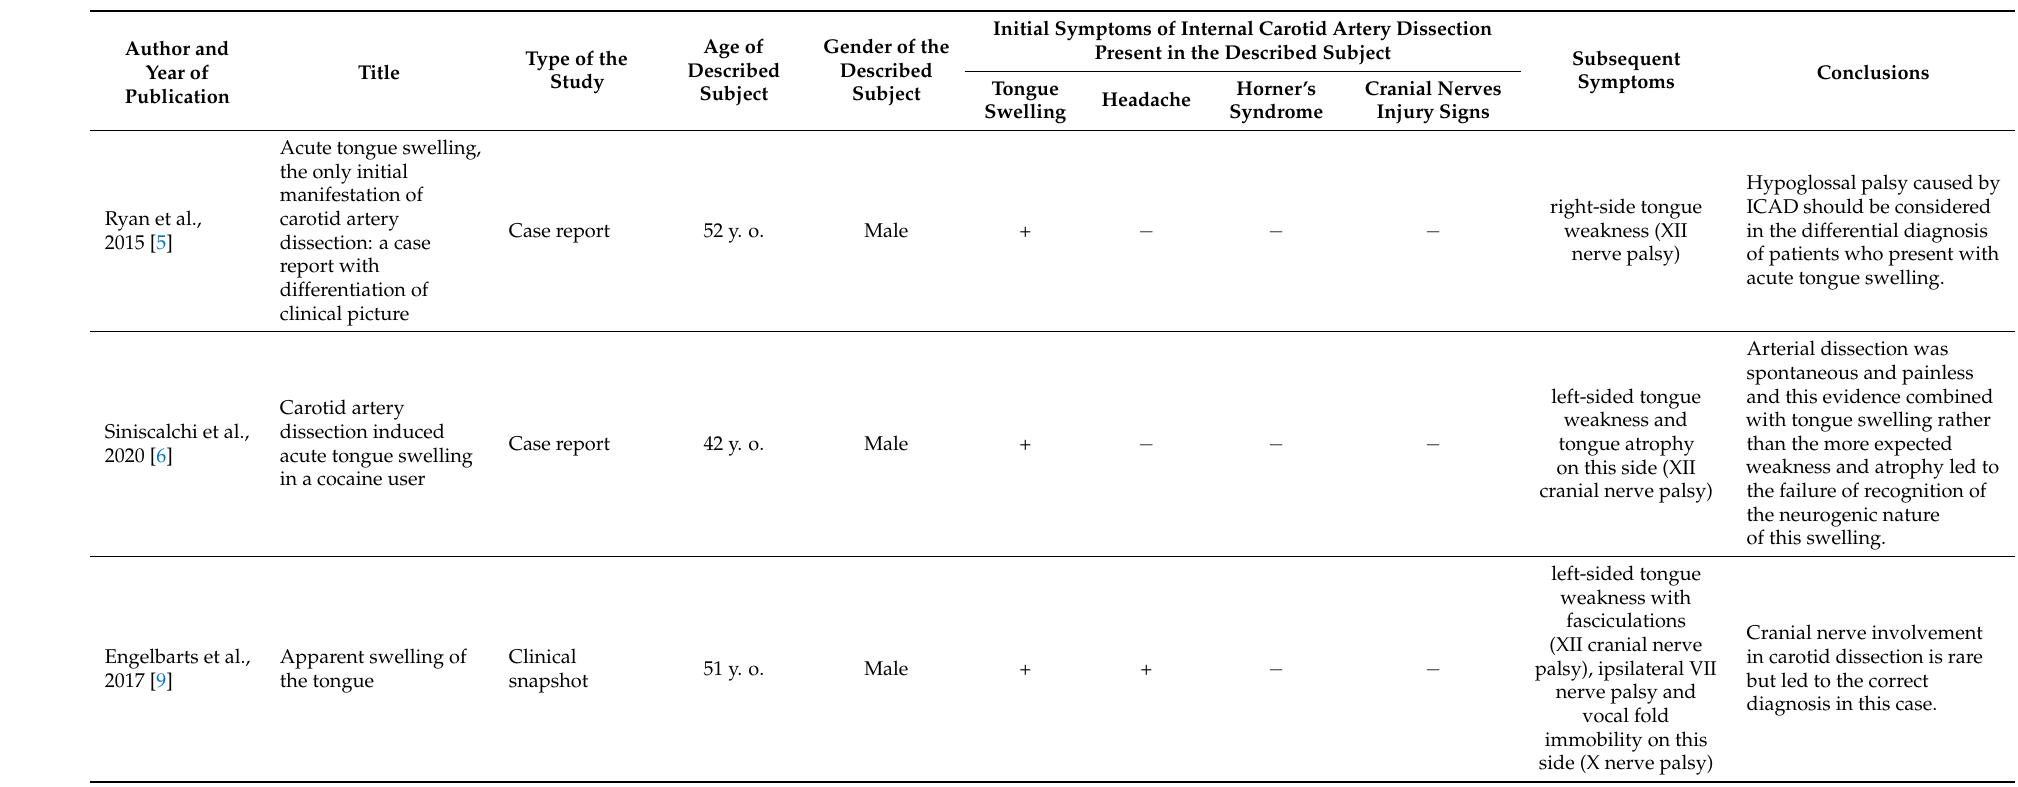
Table 1. Literature review regarding cases of carotid artery dissection with tongue swelling as one of the main